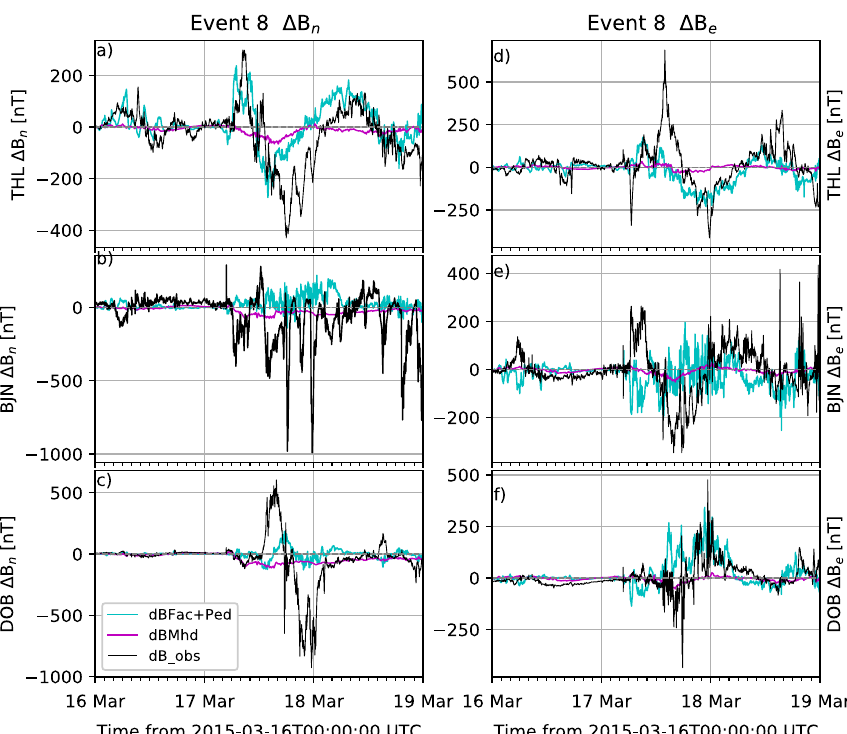
Fig. 6. Two components of ground magnetic perturbations, D B n (panels a – c) and D B e (panels d – f), at ground magnetometer stations THL, BJN, and DOB for event 8. The black line shows the observed perturbations, the cyan line shows the modelled total contribution to ground perturbations due to fi eld aligned currents (FAC) and Pedersen currents and the magenta line is the contribution from the rest of the magnetospheric